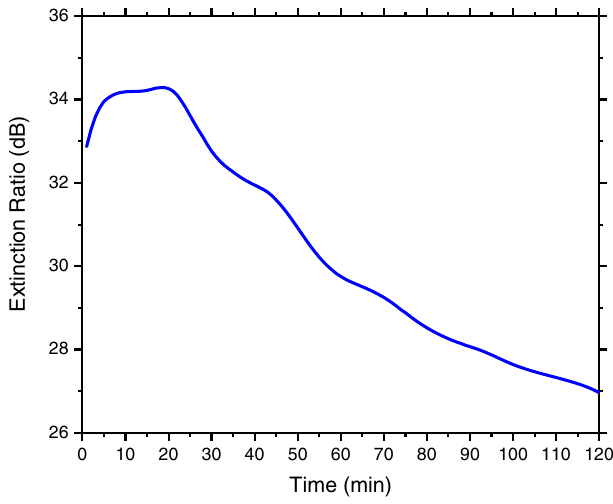
FIG. 15. Polarization stability over a 70-km single-mode fiber spool. Without active polarization control, the polarization can be stable for two hours with a polarization extinction ratio greater than 27